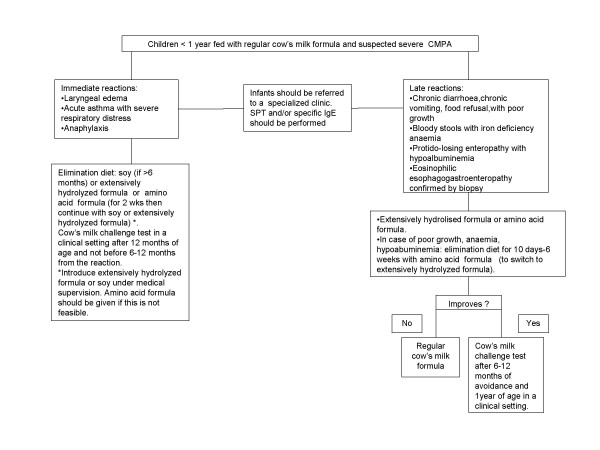
Algorithm for children <1 year fed with cow's milk formula and severe symptoms. In child less than1 year of age, infant formula is not compulsory.